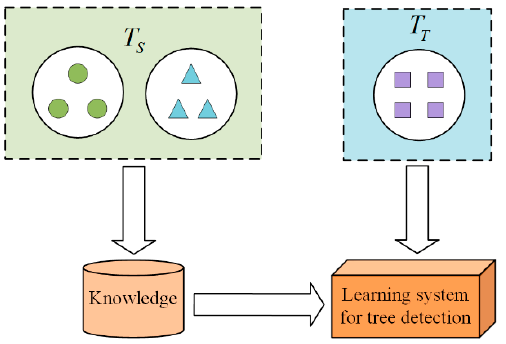
Figure 4. Transfer learning.